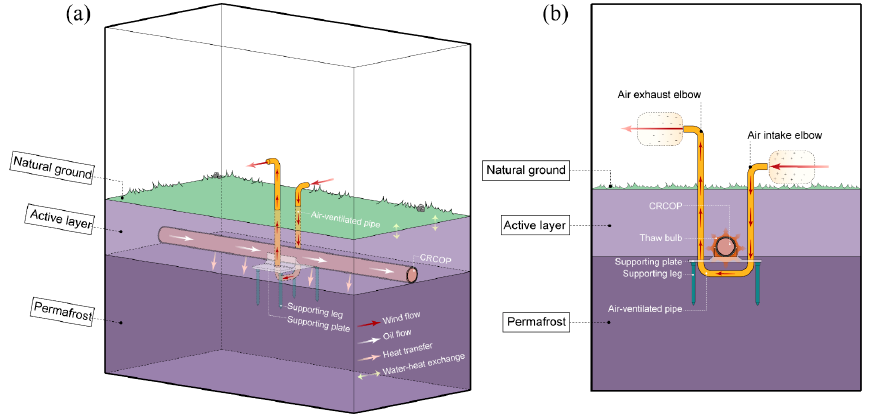
Figure 5. Schematic diagram of the proposed horizontal U-shaped air-ventilated pipe. ( a ) Axial side view and ( b ) sectional drawing.